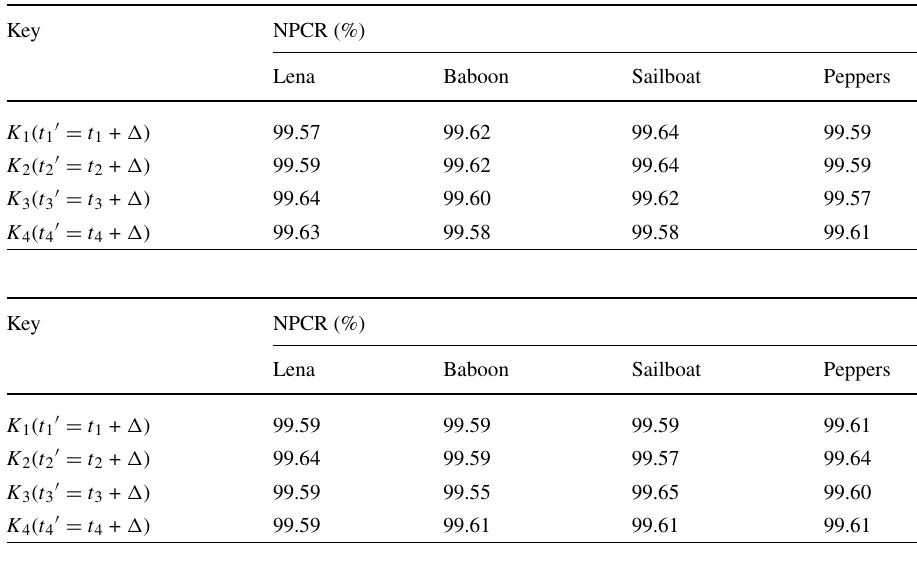
Table 8 The NPCR between two ciphertext images Key NPCR (%)